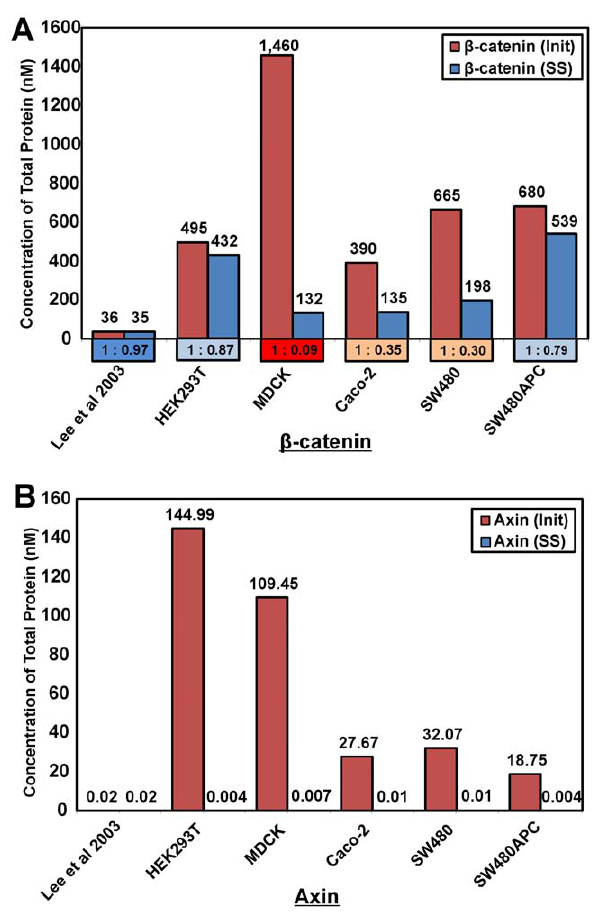
Figure 12. Total protein concentrations of b -catenin and Axin. Initial and Steady State total concentrations for Xenopus egg extract (Lee et al. , 2003) and whole cell lysate (WCL) from the mammalian cell lines. As expected, APC and GSK3 b remained stable (results not shown) due to the lack of input and output fluxes in the Lee et al. , 2003 model. Notes: For b -catenin, the ratio of total initial to steady state (I:SS) concentrations are given in the box below the bar for the respective cell line. Total protein concentration implies summation of concentrations of free and all protein complexes containing the specific protein.